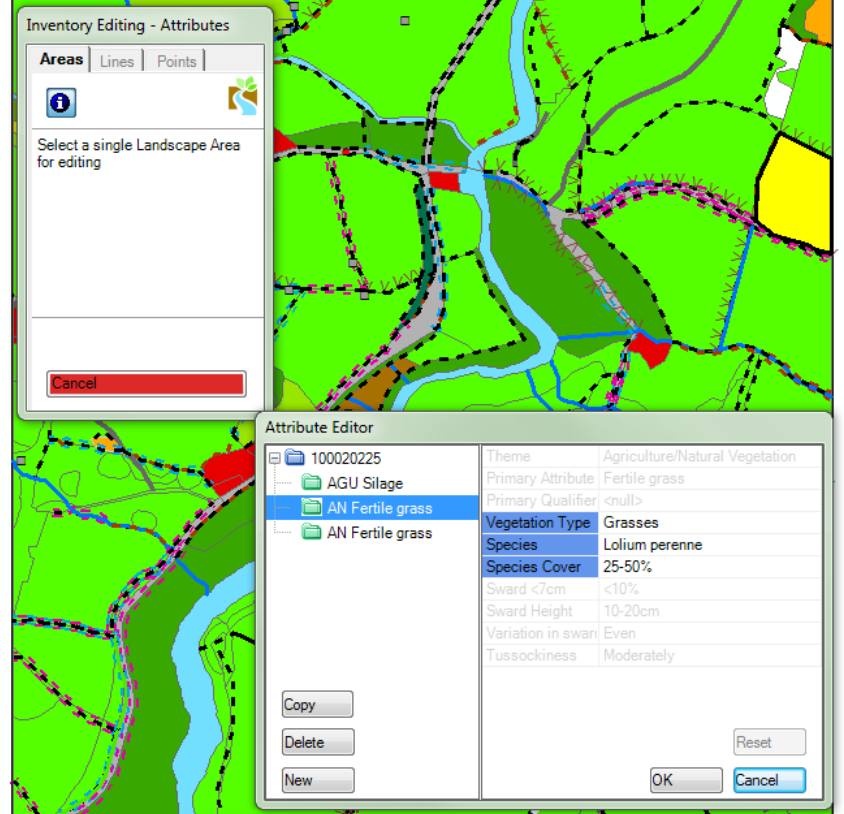
Figure 4. Example of digital mapping